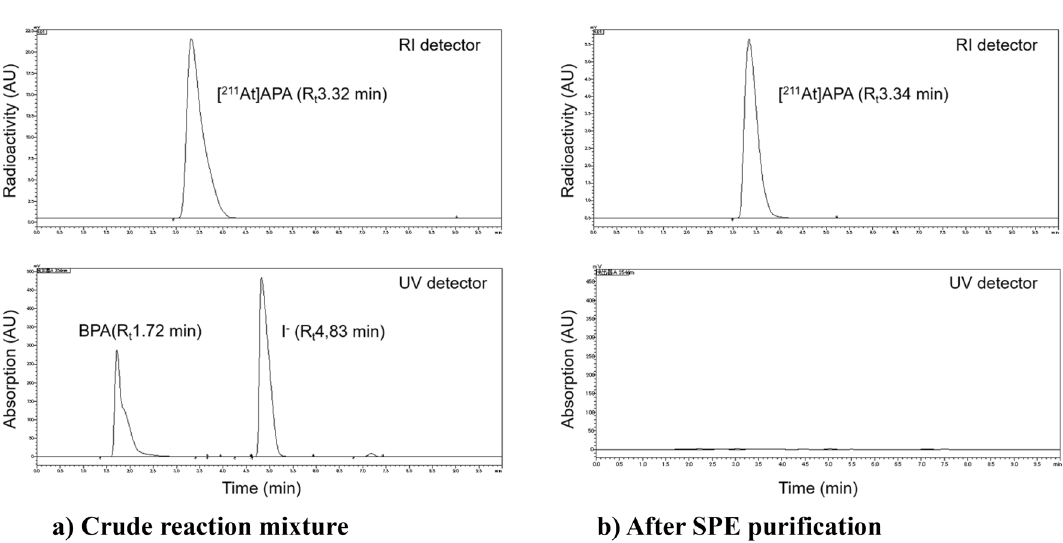
Figure 3. HPLC profiles of [ 211 At]APA synthesized by the KI method. ( a ) Crude reaction mixture, ( b ) after SPE purification. Top panel: Radioactive trace; Bottom panel: UV